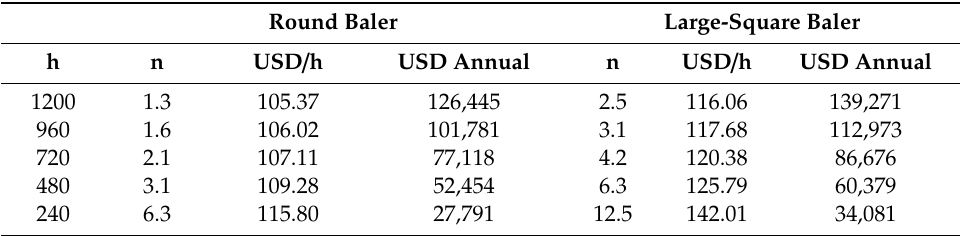
Table 2. Cost factors for balers as a function of annual use. (n = number of useful yrs of design life). Round Baler